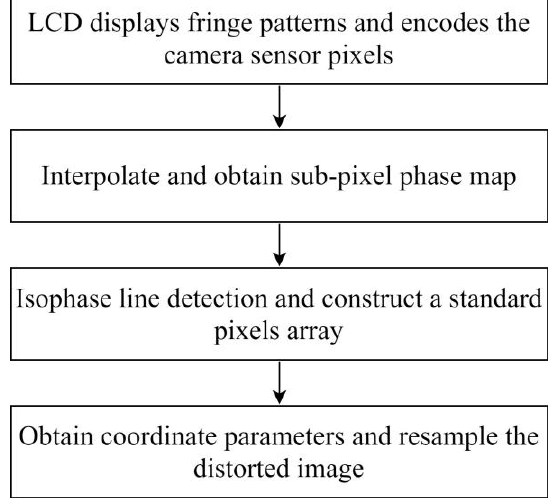
Figure 6. The process of distortion correction.